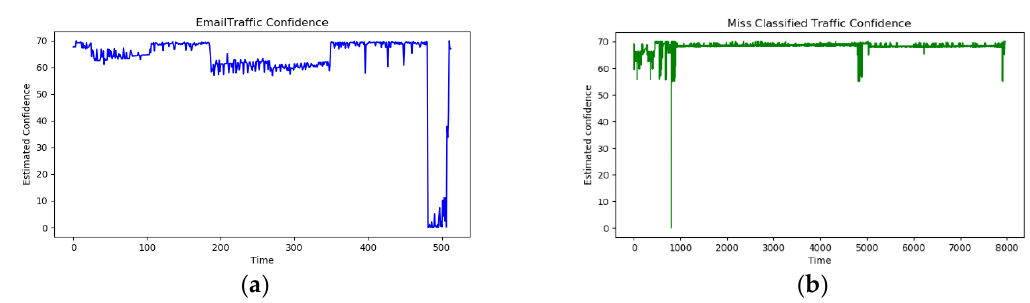
Figure 12. Confidence value trend of packets whose membership level is the highest for email type among all data. ( a ) shows the distribution of actual email type data. ( b ) shows the distribution of the misclassified data.